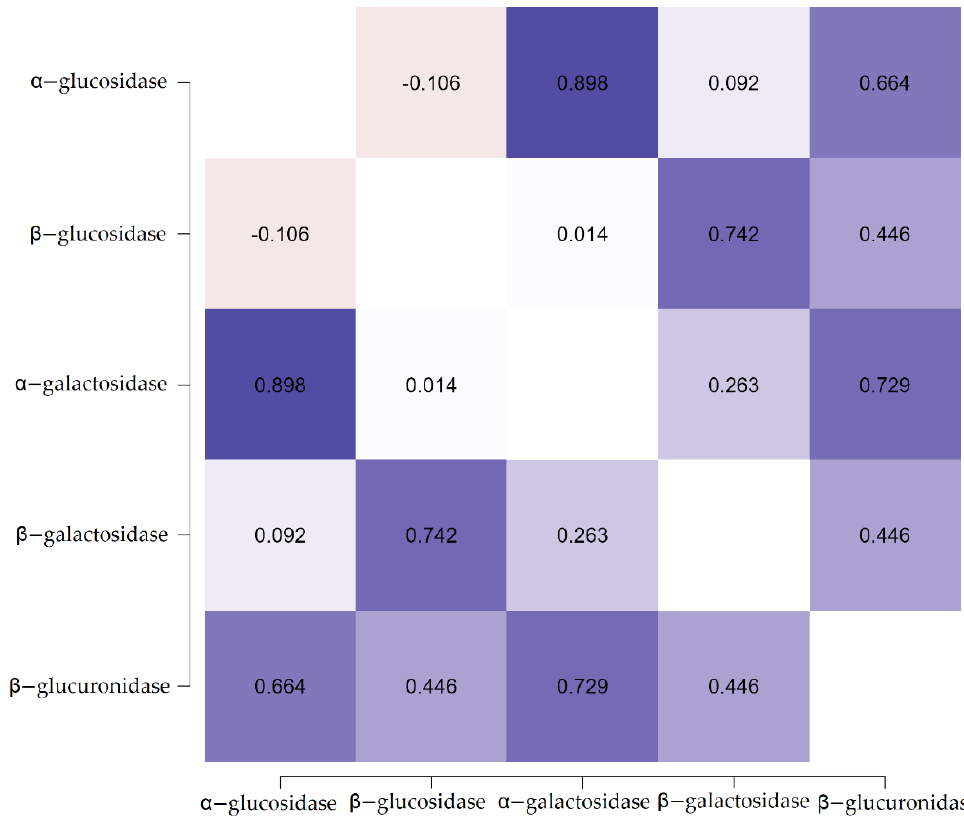
Figure 5. Graphical representation of correlations between the different fecal enzymes with a partial Pearson’s r heatmap.